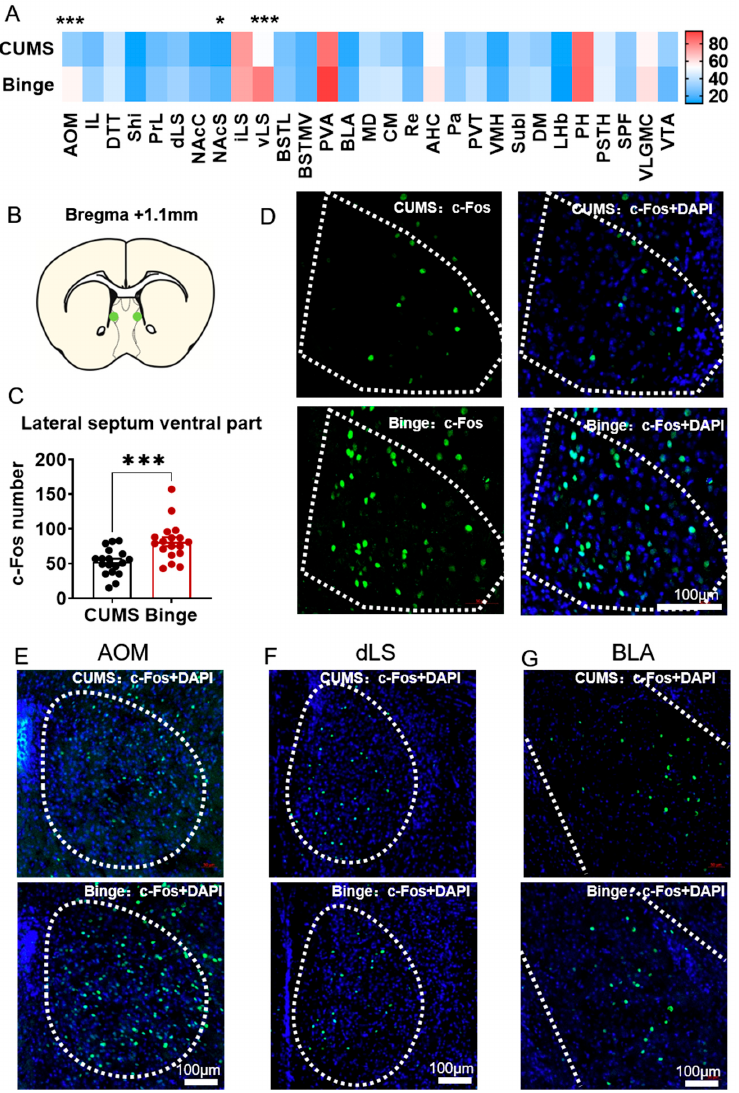
Figure 6. c-Fos showed different activation in lateral septum ventral part (vLS) after binging. ( A ). c-Fos mapping of brain regions in binging mice. ( B – D ). Sketch map of c-Fos-positive cells in vLS. ( E – G ). c-Fos-positive cells in AOM, dLS, and BLA. N = 3. Data were analyzed by student t -test and two-way ANOVA and are shown as mean ± SEM. *, p < 0.05. ***, p < 0.001. Abbreviations: AOM anterior olfactory nucleus medial part, IL infralimbic cortex, DTT dorsal tenia tecta, SHi septohippocampal nucleus, PrL prelimbic cortex, dLS lateral septal nucleus dorsal part, NAcC accumbens nucleus core, NAcSh accumbens nucleus shell, iLS lateral septal nucleus intermediate part, vLS lateral septal nucleus ventral part, BSTL bed nucleus of the stria terminalis lateral division, BSTMV bed nucleus of the stria terminalis medial division ventral part, PVA paraventricular thalamic nucleus anterior part, BLA basolateral amygdaloid nucleus anterior part, MD mediodorsal thalamic nucleus, CM central medial thalamic nucleus, Re reuniens thalamic nucleus, AHC anterior hypothalamic area central part, Pa paraventricular hypothalamic nucleus, PVT paraventricular thalamic nucleus, VMH ventromedial hypothalamic nucleus, SubI subincertal nucleus, DM dorsomedial hypothalamic nucleus, LHb lateral habenular nucleus, PH posterior hypothalamic area, PSTH parasubthalamic nucleus, SPF subparafascicular thalamic nucleus, VLGMC ventral lateral geniculate nucleus magnocellular part, VTA ventral tegmental